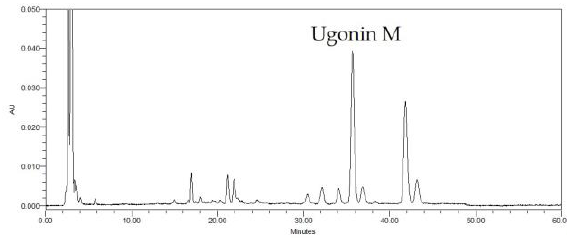
Figure 1. Chromatographic analysis of H. zeylanica detected at 360 nm. The major peak on the chromatography of the ethanol extract of H. zeylanica was identified as standard Ugonin M compound.